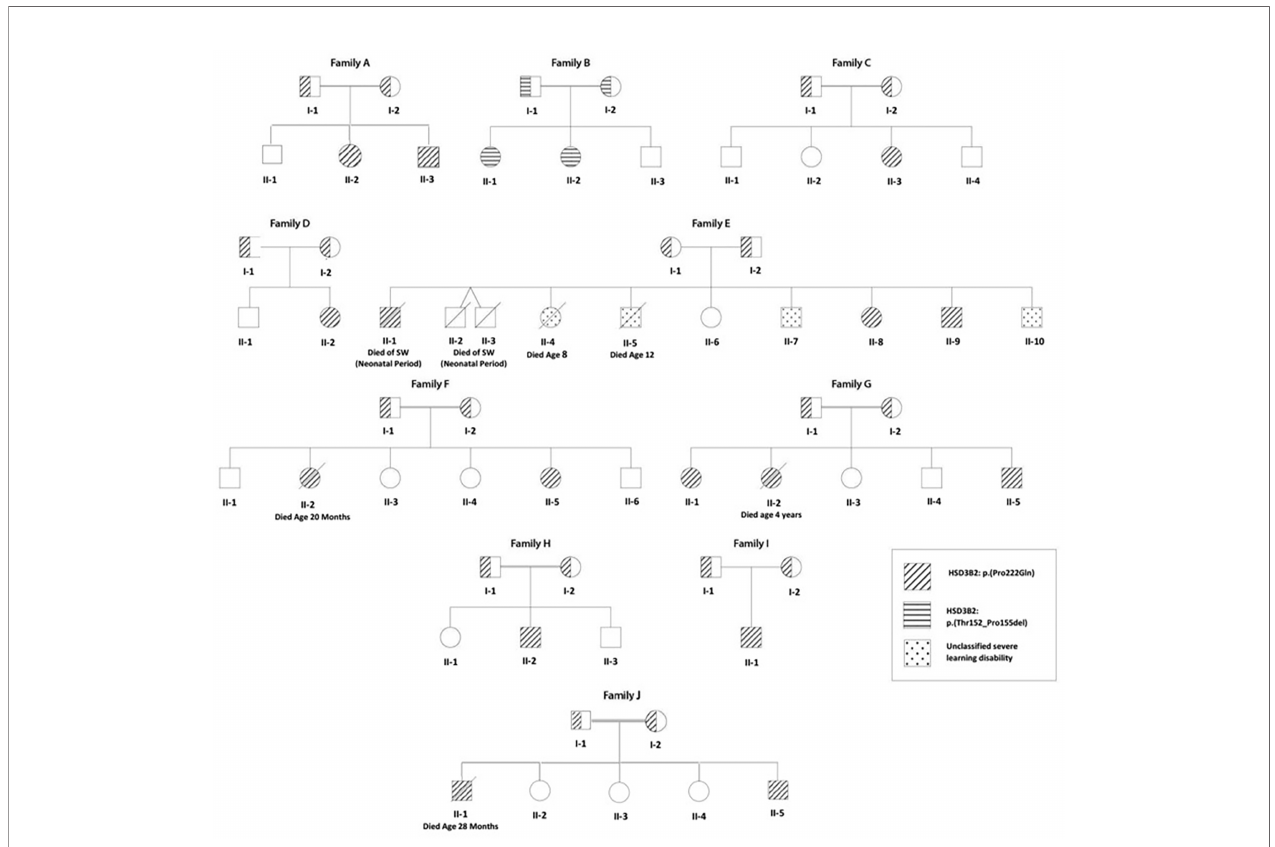
FIGURE 1 | Family tree of 10 Algerian families (8 consanguineous) with a) 3 b HSD2 de fi ciency (individuals shown as hatched circles or squares); and b) an unclassi fi ed severe learning disability syndrome (affected individuals shown as speckled circles or squares). A HSD3B2: p.Pro222Gln mutation was found in 9 families (diagonal hatching), while Family B shows a novel HSD3B2: p.Thr152_Pro155del mutation (horizontal hatching). Of 42 children born to the 10 families, 3 b HSD2 de fi ciency was genetically proven in 18 (2 deaths) and suspected on clinical grounds in twins from Family E with neonatal death from